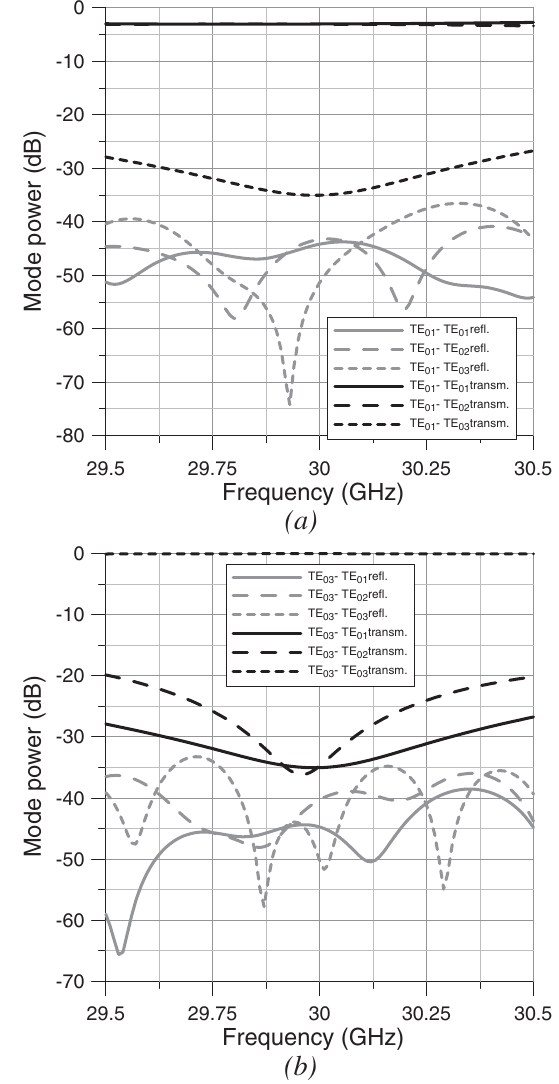
FIG. 11. Mode conversion at TE coupler: (a) left-to-right TE mode is TE 03